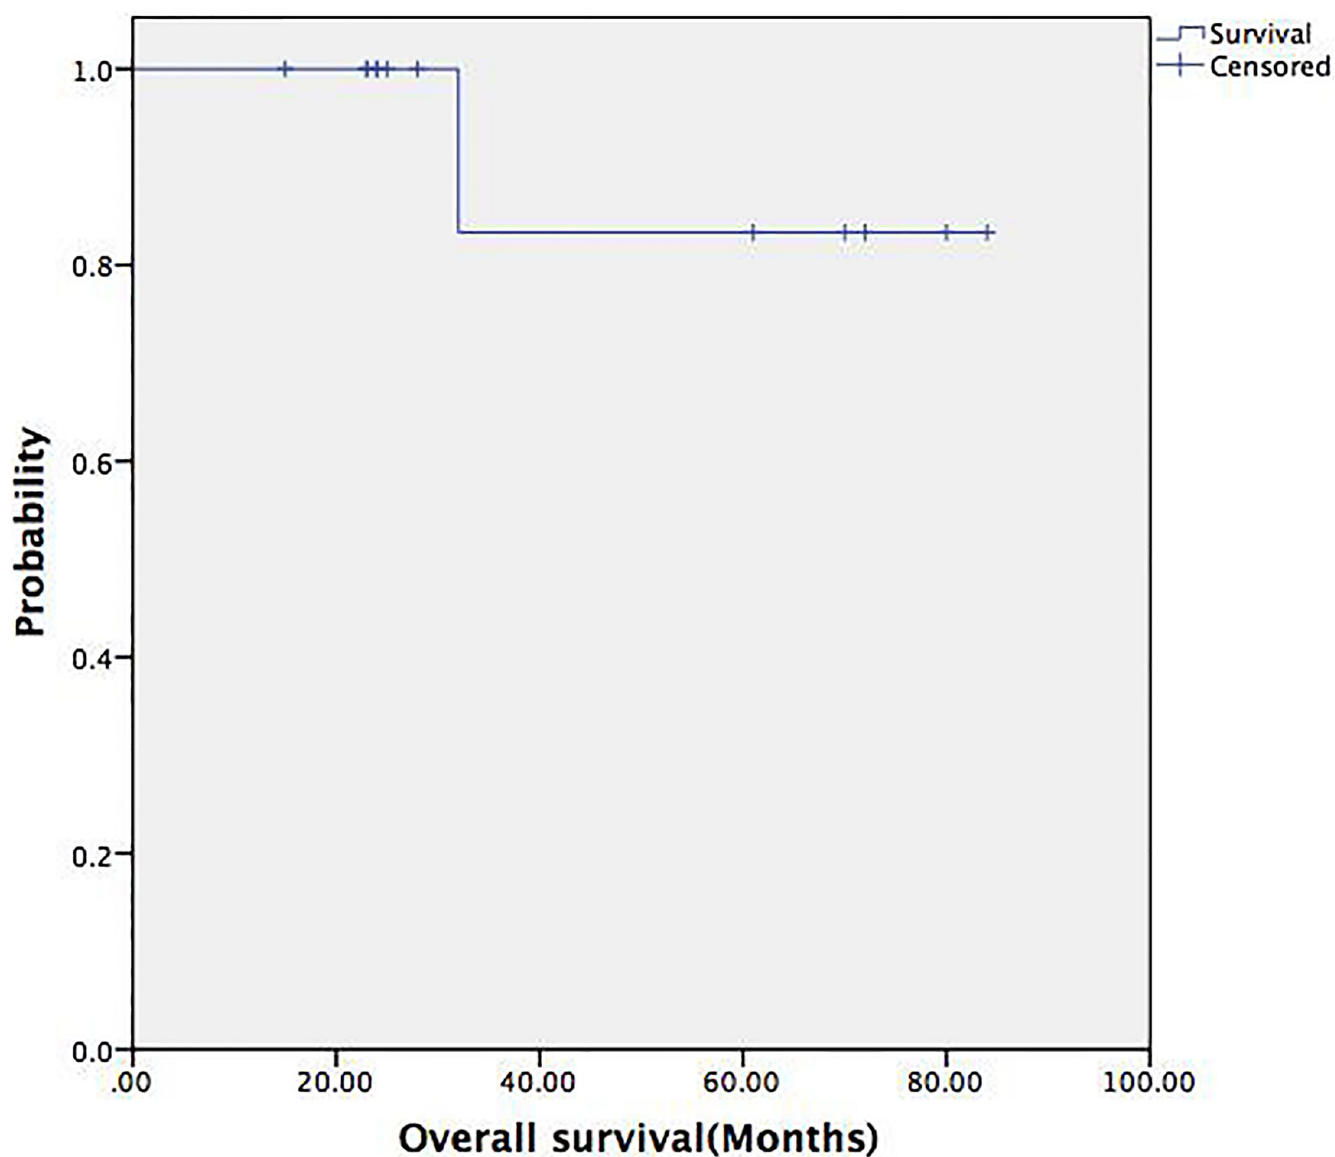
Fig 1. Overall survival curve of the 13 patients. The 5-year survival rate was